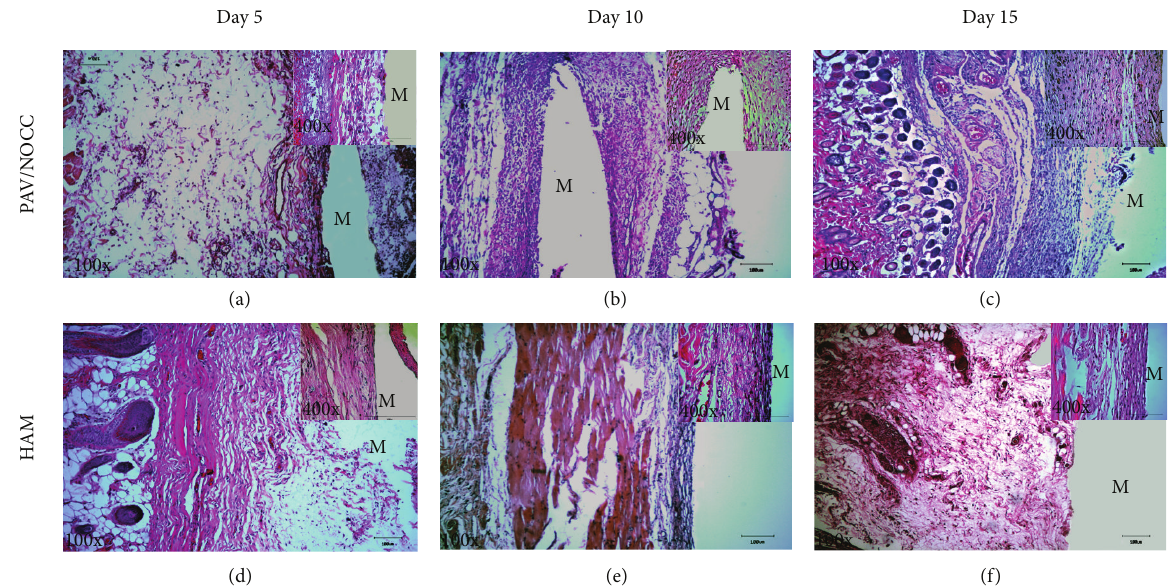
Figure 2: Histological sections and H&E staining of the PVA hydrogel and HAM after 5, 10, and 15 days of subcutaneous implantation. “M” indicates the implantation sites, 100x (low) and 400x (high). The high magnification photograph indicates the inflammatory infiltrates after implantation at variable time